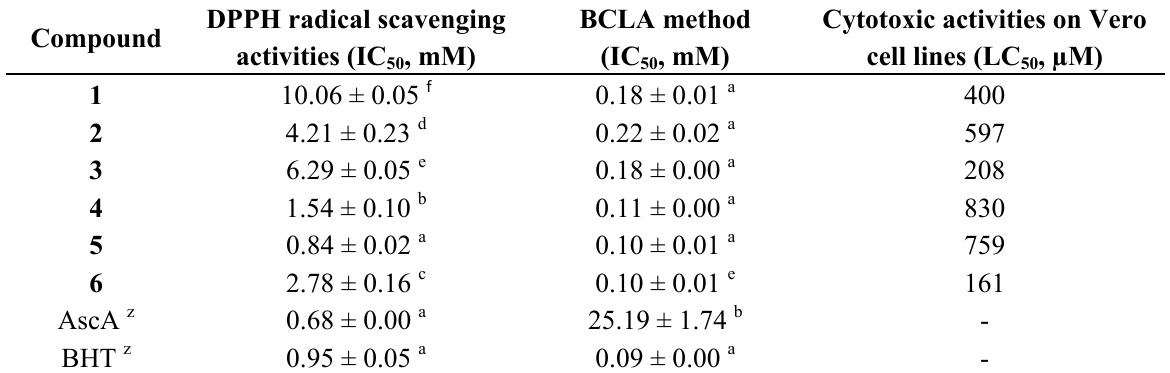
Table 3. Antioxidant and cytotoxic activities of compounds 1 to 6